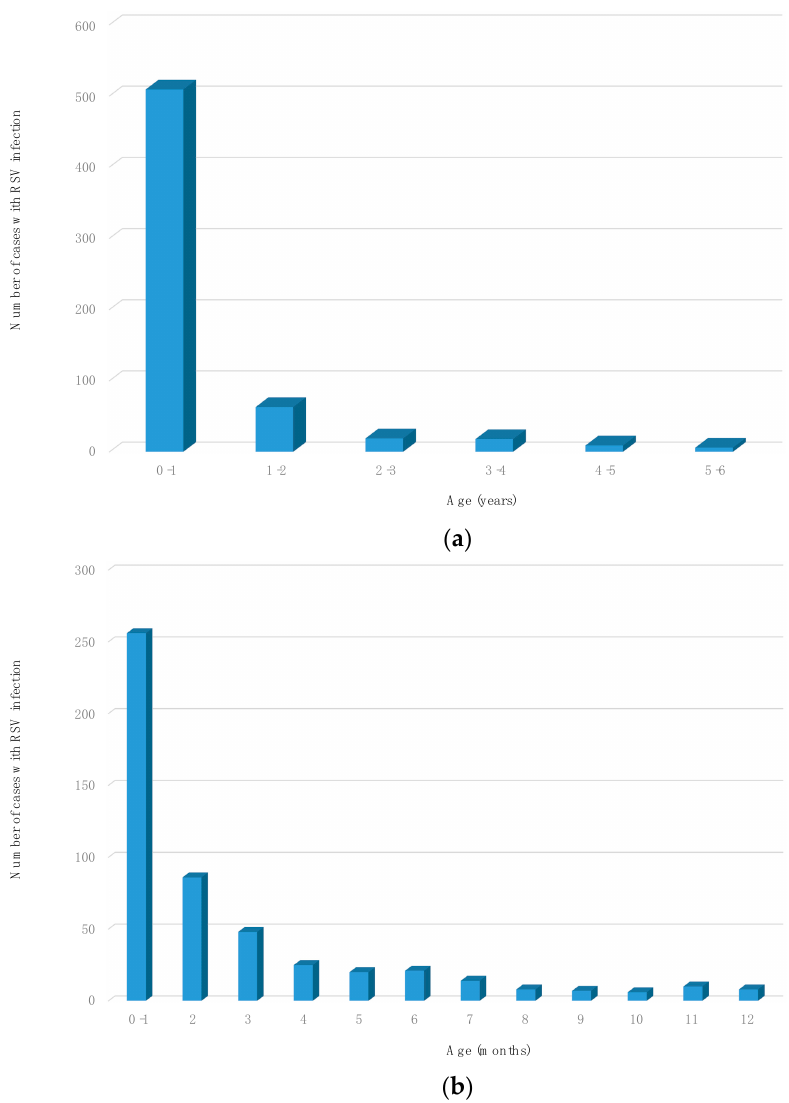
Figure 2. Number of cases of RSV infection: ( a ) cases divided by age expressed in years; ( b ) cases between 0 – 1 year ‐ old divided by age expressed in months.